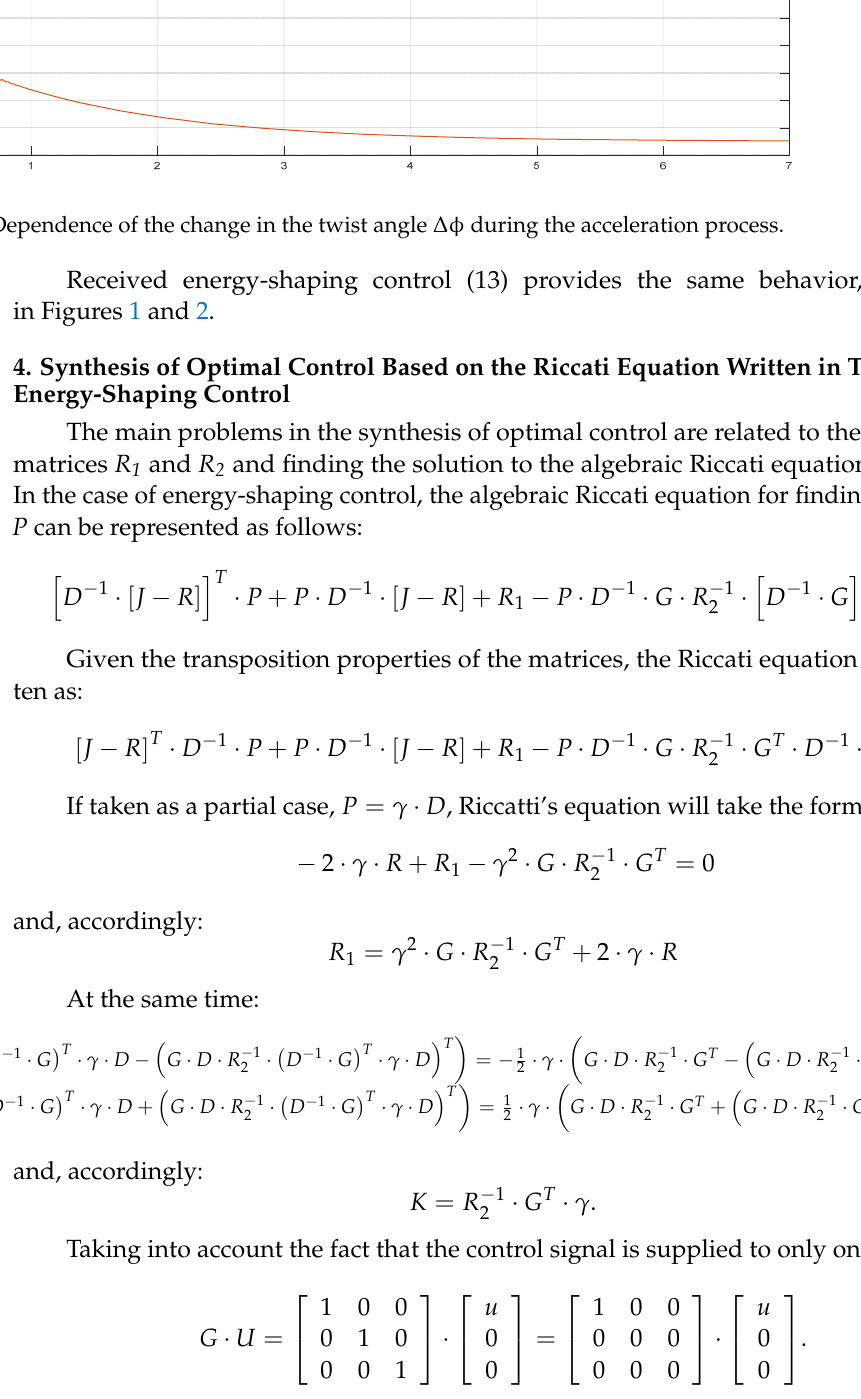
ϕΔ during the acceleration process.